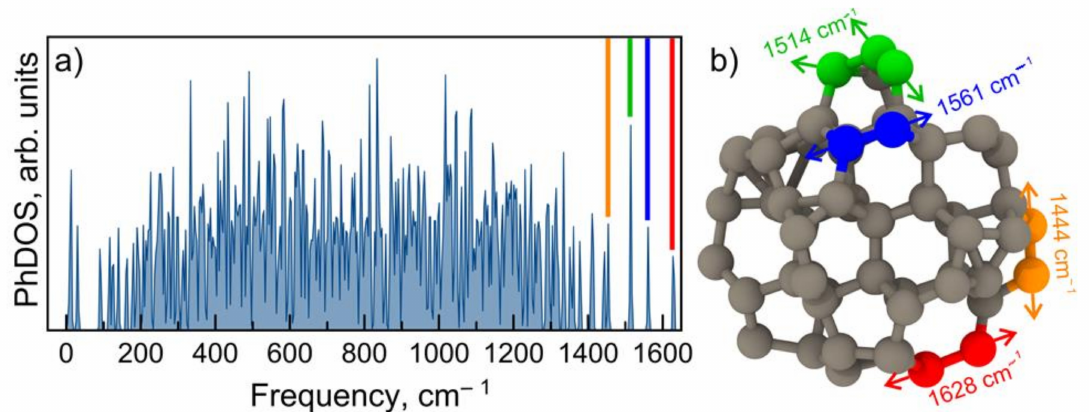
Figure 2. ( a ) Phonon density of states of considered nanodiamonds. ( b ) Visualization of atomic vibrations corresponding to high-frequency phonon modes. Colored bands in ( a ) display phonon modes, which are visualized in ( b ). Arrows denote the direction of atom